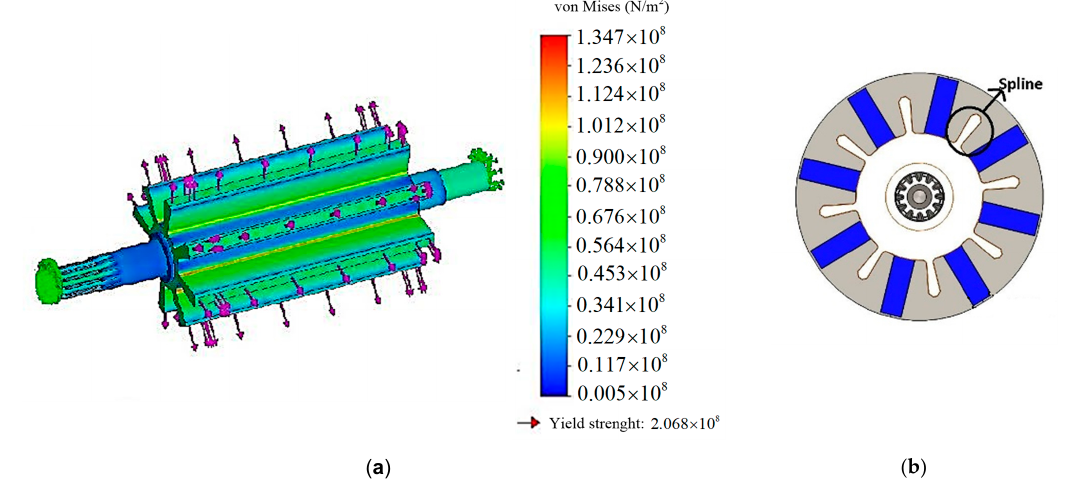
Figure 17. Shaft and rotor designs: ( a ) final shaft design and ( b ) ultimate rotor’s magnetic circuit.